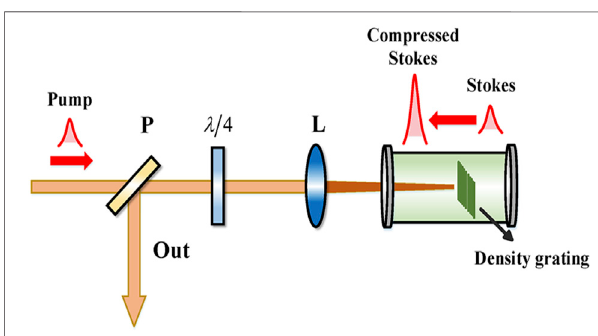
FIGURE 3 | Schematic diagram of focusing single cell